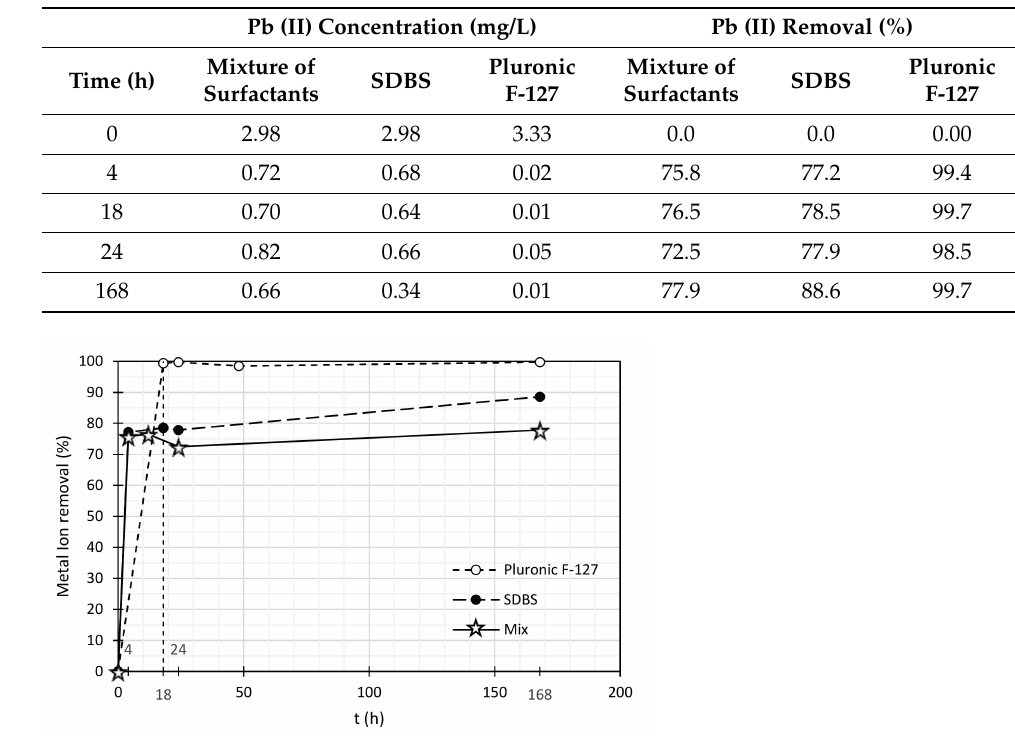
Table 10. Pb (II) removal applying a suspension of 0.01% ( w / w ) of MWCNTs dispersed by a mixture of SDBS and Pluronic F-127, 0.03% ( w / w ) of SDBS and 0.03% ( w / w ) of Pluronic F-127.